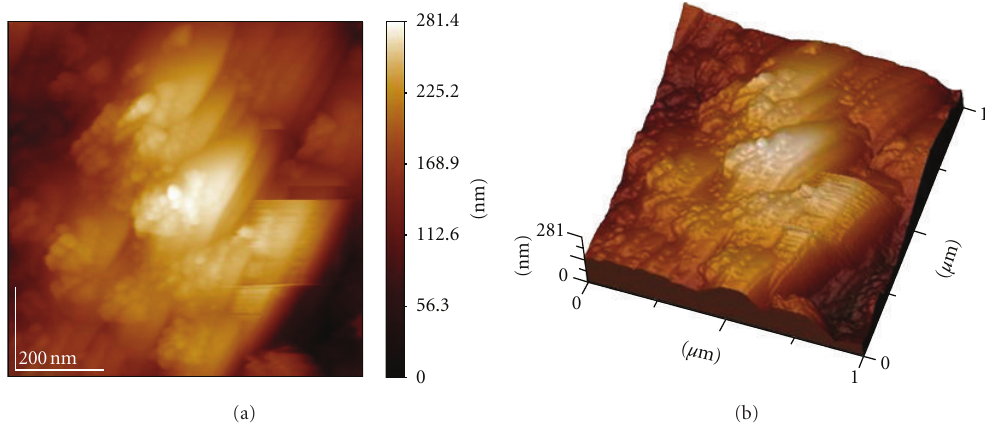
Figure 7: 2-dimension and 3D AFM image of the as-coated HA.